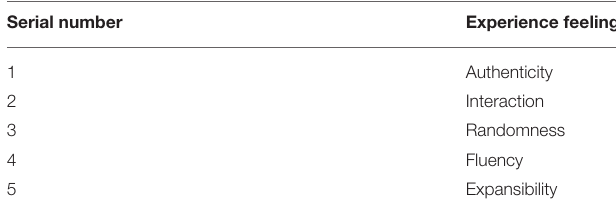
TABLE 6 | Scene interaction process of virtual tourist